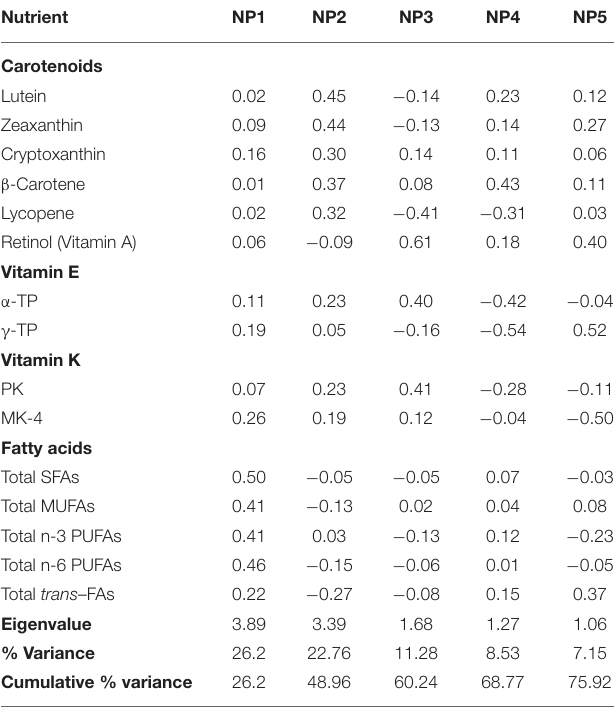
TABLE 3 | Construction of nutrient patterns (NPs), NP structure and variance explained ( n =